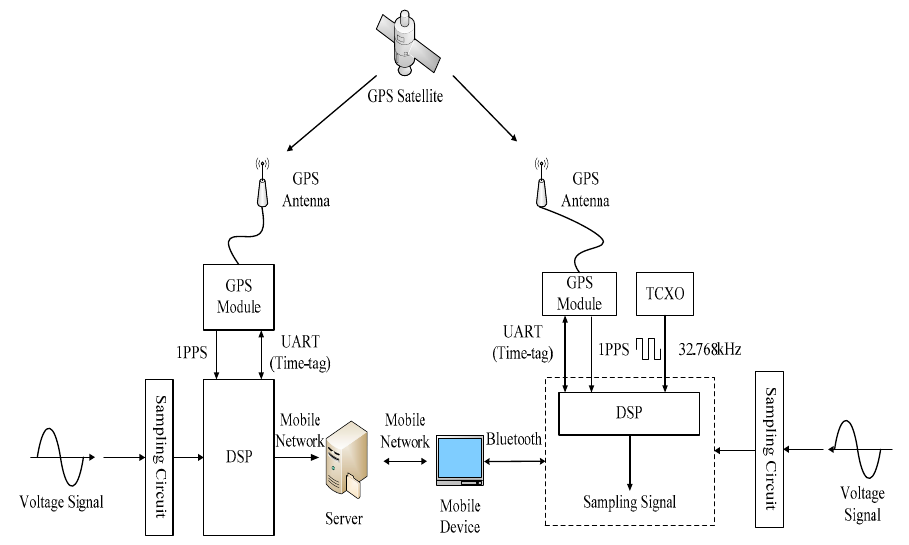
Figure 4. Framework of the voltage phasor comparison.